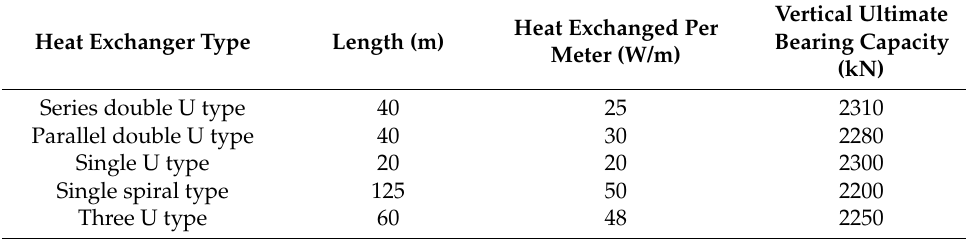
Table 2. Primary parameters of heat